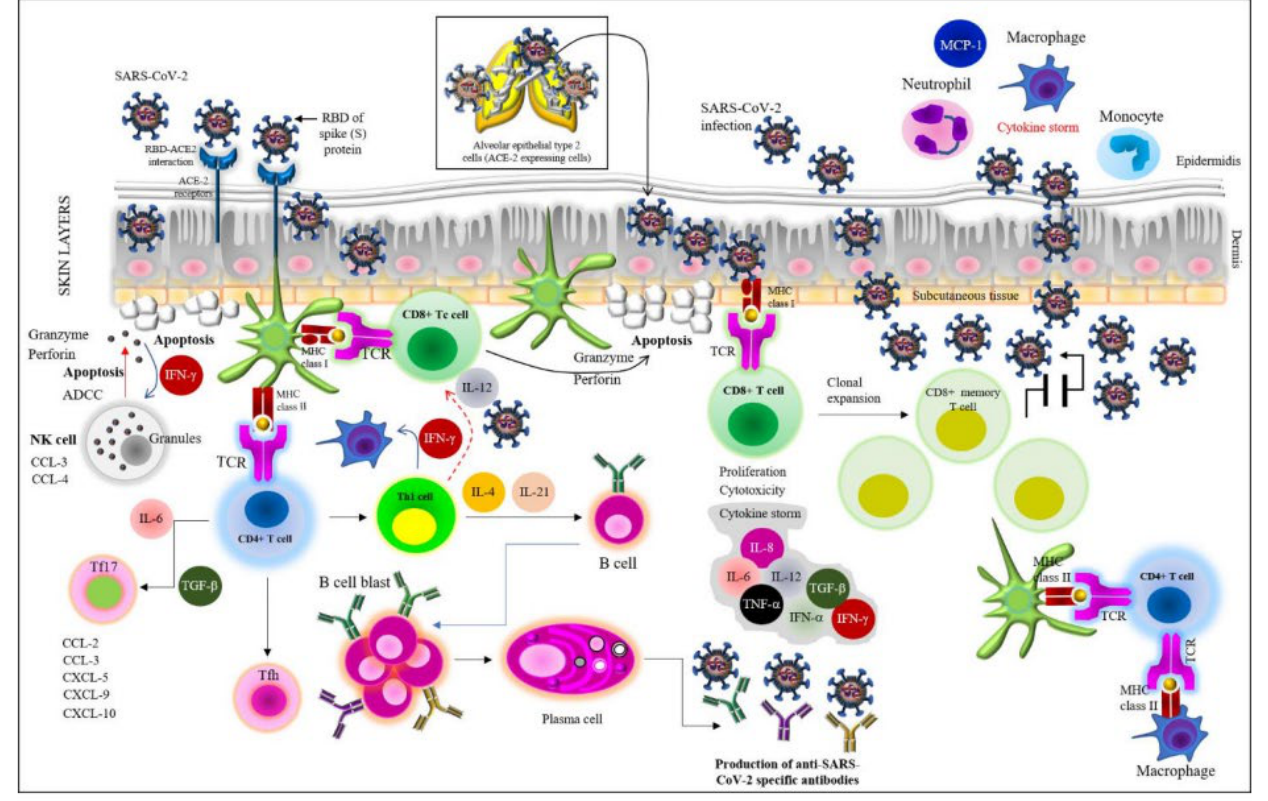
Figure 1. Induction of host immunity against SAR-CoV-2 infection. Details are given in the text.